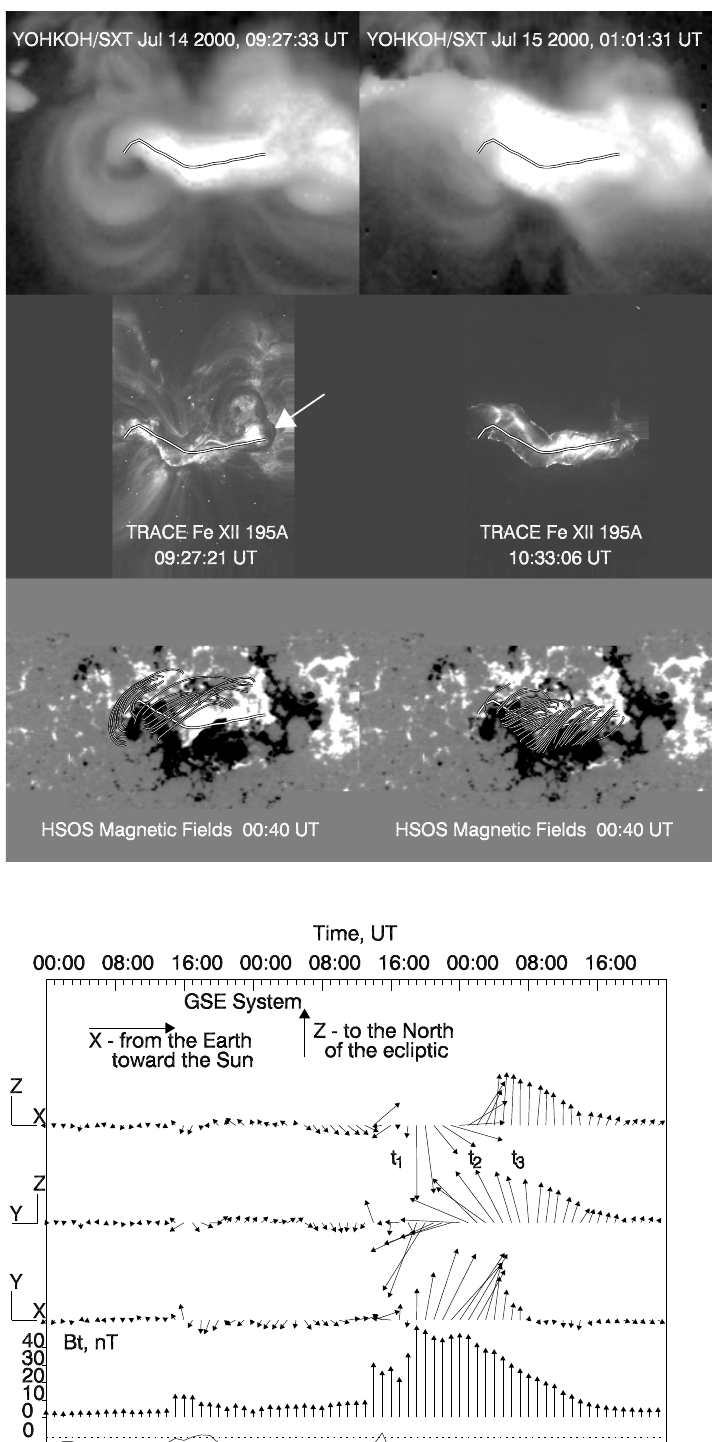
Fig. 8. Plot of 1-h averages of the IMF in the 15 July 2000 MC near the La- grange point, L1. Magnetic field com- ponents are plotted in the GSE system, where X -axis points from the Earth to- ward the Sun, Y is in the ecliptic plane and negative in the direction of plan- etary motion, and Z is parallel to the ecliptic pole. Two bottom panels show the variations of the IMF strength and the D st